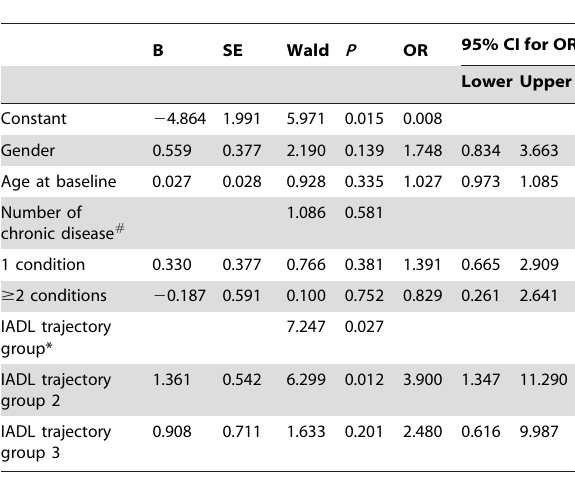
Table 4. Logistic regression for adverse CESD group